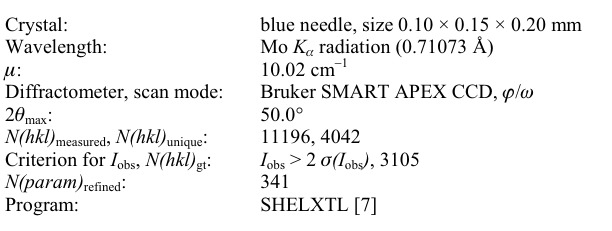
Table 1. Data collection and handling.